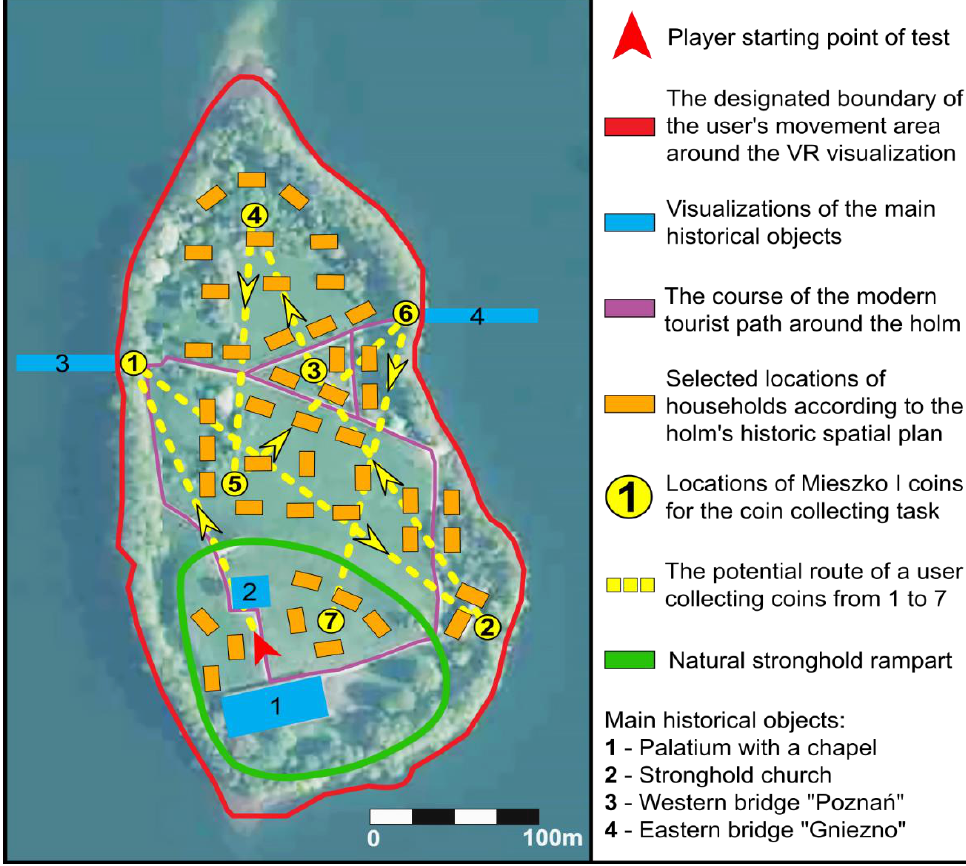
Figure 2 . Layout of the application with the placement of individual game elements on the holm.